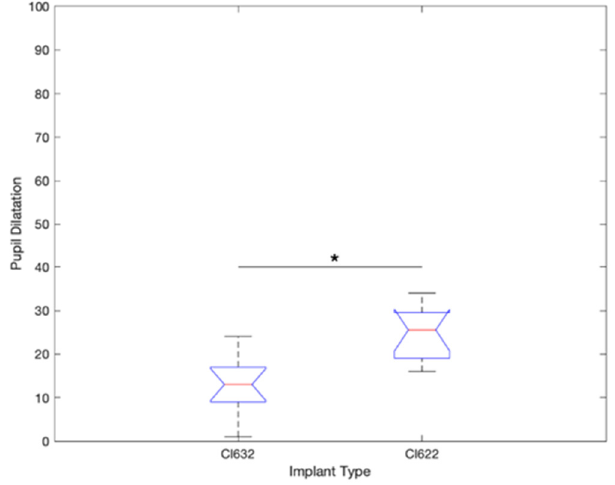
Figure 3. Pupil dilatation result comparison chart between CI632 and CI622 recipients during electrode discrimination test (* p < 0.05).